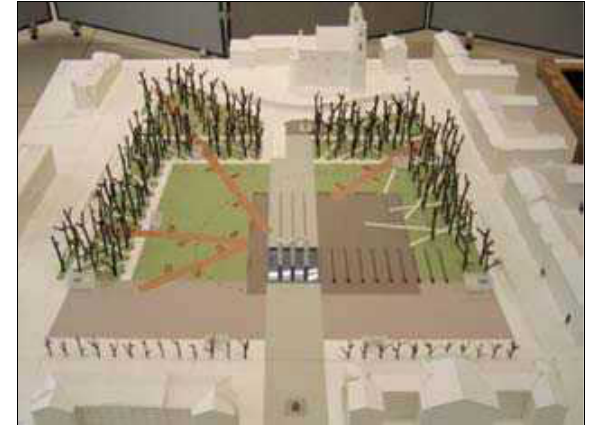
Fig. 5. Lukiškės Square reconstruction competition. Project